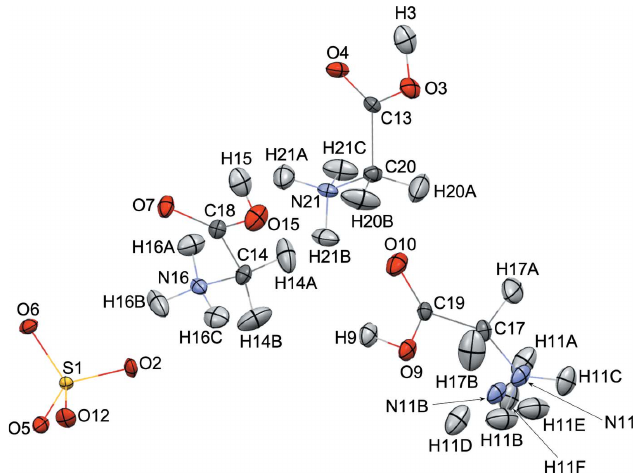
Figure 4 The molecular structure of HTGS at 298 K (model 2) showing 50% displacement ellipsoids for all